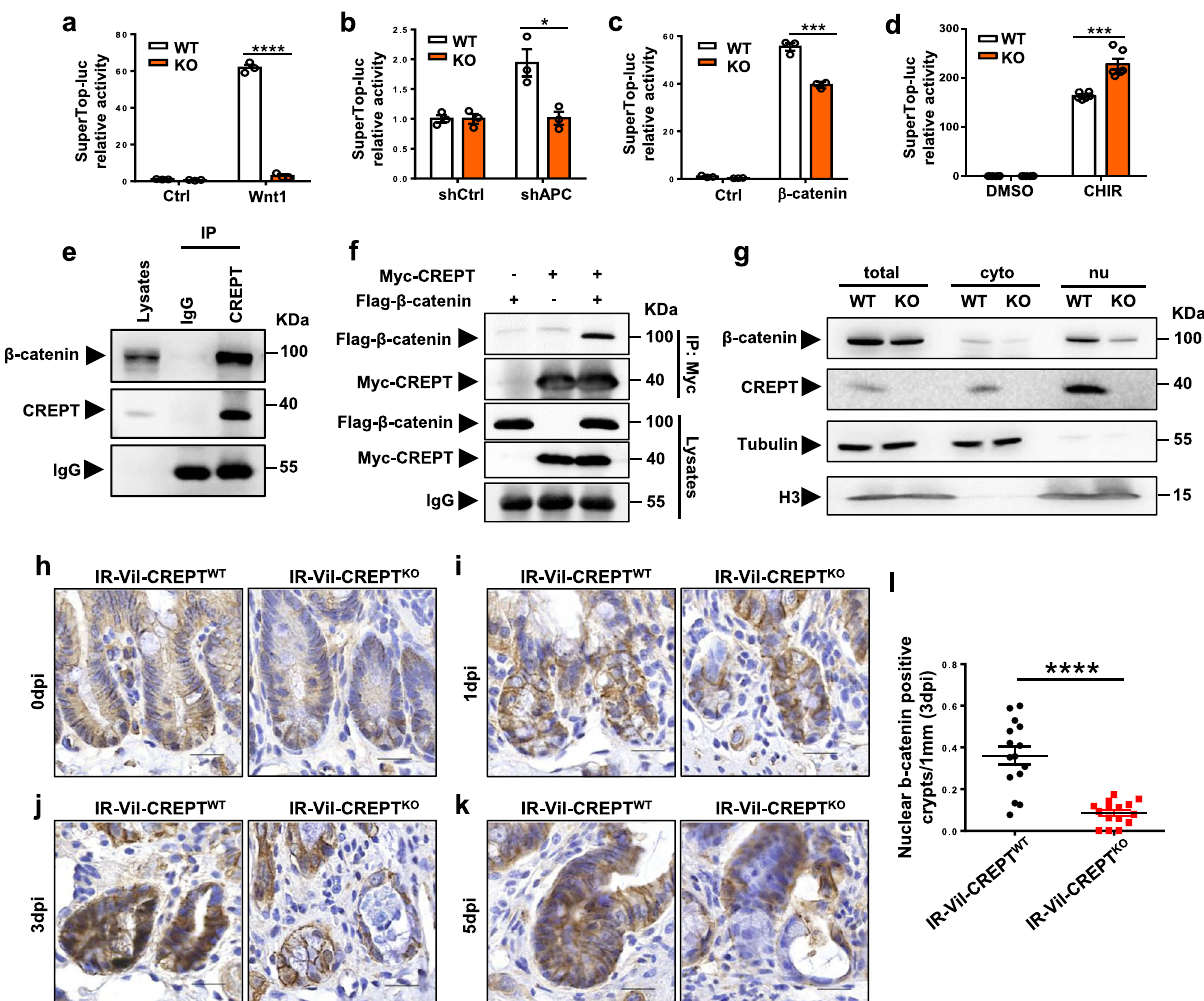
Fig. 6 CREPT assists β -catenin retaining in the crypt nuclei. a – d CREPT deletion impaired the SuperTop luciferase activity stimulated by Wnt1 ( a ), APC depletion ( b ), β -catenin ( c ), and CHIR99021 ( d ). CREPT was deleted by a CRISPR-Cas9 system in HEK293T cells. SuperTop-luciferase reporter and pRL-TK plasmids transfected WT and CREPT deleted HEK293T cells were co-transfected with Wnt1 ( a ), shAPC ( b ), and β -catenin ( c ) plasmids, or treated with 5 μ M CHIR99021 for 4 h ( d ). The activity was expressed as fold-changes, normalized by an internal control (Renilla). p < 0.0001 ( a ). p = 0.0168 ( b ). p = 0.0009 ( c ). p = 0.0002 ( d ). n = 3 independent experiments for each treatment. e Endogenous CREPT interacts with β -catenin. Cell lysis of intestinal crypts was incubated with control IgG or anti-CREPT antibodies. The immunoprecipitants were analyzed by Western Blotting using anti- β -catenin or anti- CREPT antibodies. f Exogenous CREPT interacted with β -catenin. Myc-tagged CREPT (Myc-CREPT) and FLAG-tagged β -catenin (Flag- β -catenin) were co- expressed in HEK293T cells. g CREPT deletion reduced the nuclear protein level of β -catenin. CREPT was deleted by the CRISPR-Cas9 system in DLD1 colorectal tumor cells. β -catenin proteins were analyzed by Western blotting in cytoplasmic and nuclear fractions of WT and CREPT KO DLD1 cells. h – k Representative images of β -catenin IHC staining in crypts at 0, 1, 3, and 5 dpi after X-ray irradiation, respectively. Obvious nuclear β -catenin appeared at 3 dpi of WT mice, but not Vil-CREPT KO mice. l Quanti fi cation of nuclear β -catenin positive crypts per 1 mm intestine at 3 dpi. p < 0.0001. n = 3 mice per genotype. Images are representative of at least three independent experiments ( n = 3 mice per genotype). Statistics data represent mean ± SEM. All p values were generated by 2-tailed Student ’ s t -test. Scale bars: 20 μ m ( h – k